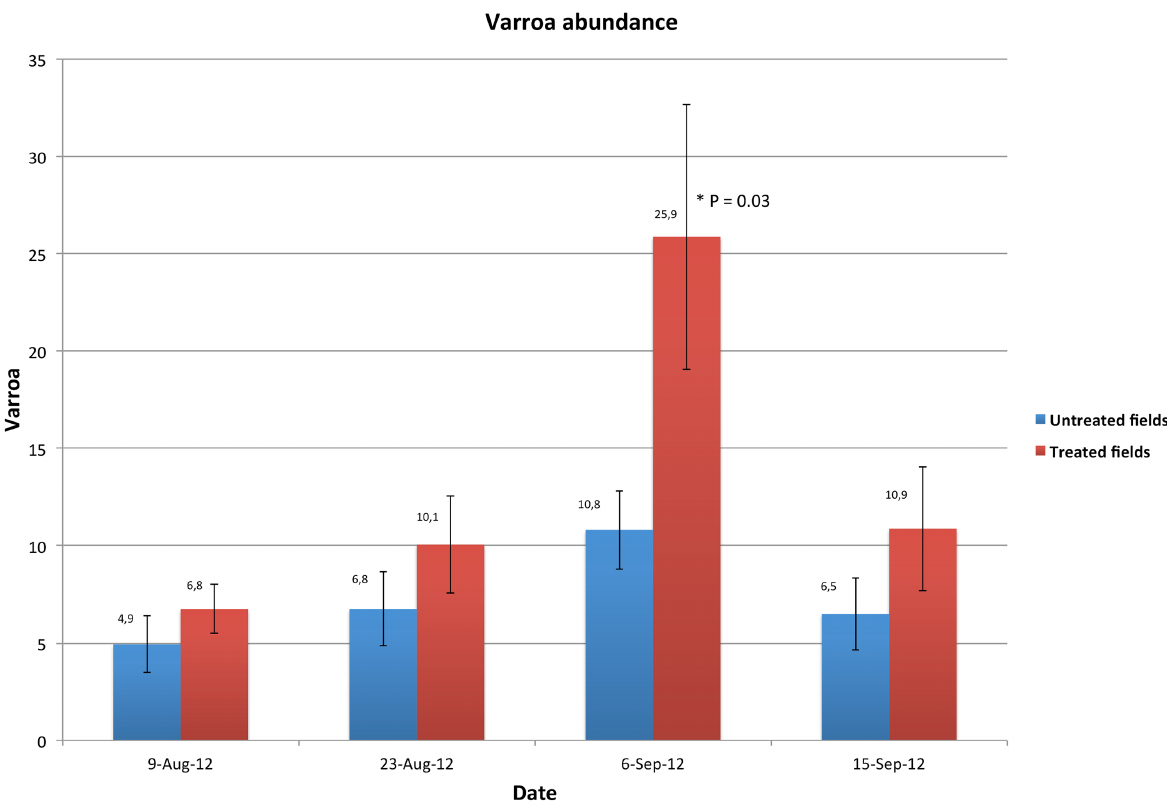
Fig 4. Mean values of varroa mite abundance in the 32 studied colonies, 16 colonies in each treated and untreated cornfields on four different dates. Error bars are the Standard Errors (SE) of each studied group. P values is * P <